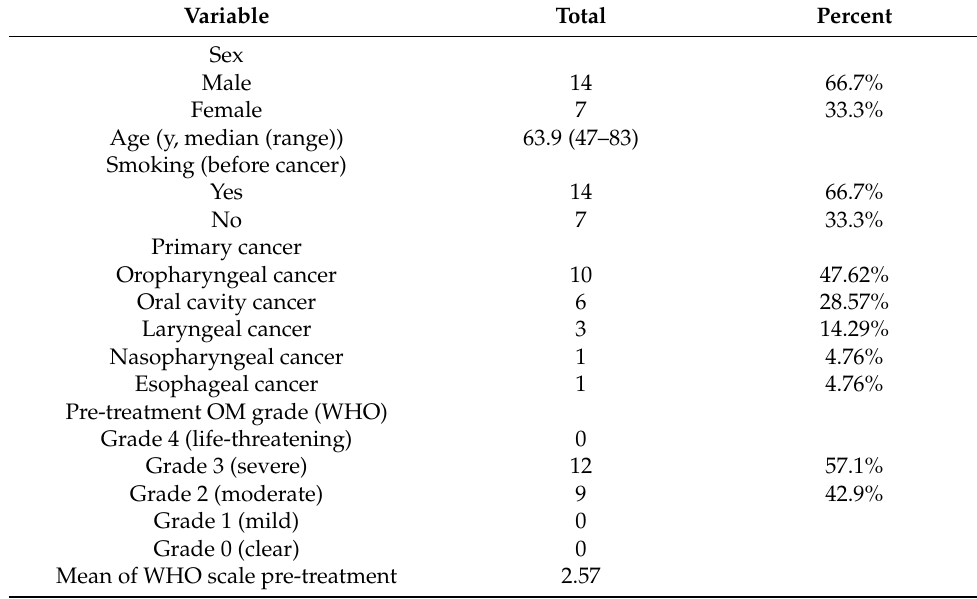
Table 3. Baseline characteristics of the